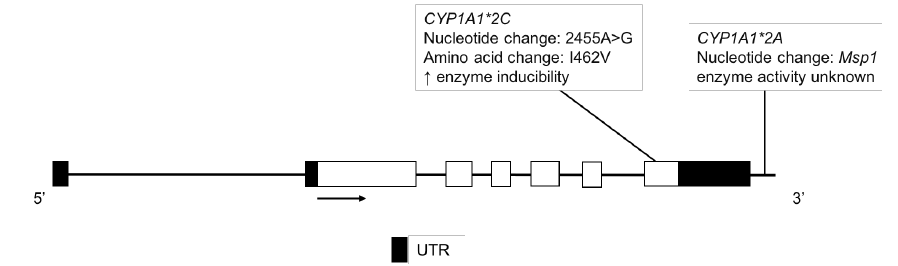
Figure 3. The human CYP1A1 gene and variants detected in two Amerindian populations. Exon 1 is untranslated in CYP1A1. Open boxes represent exons, lines represent introns and shaded boxes represent untranslated region (UTR). Table 2. Comparison of CYP1A1 allele frequencies in Indigenous North American populations to global populations from the 1000 Genomes Project [20]. N represents the number of alleles. Global